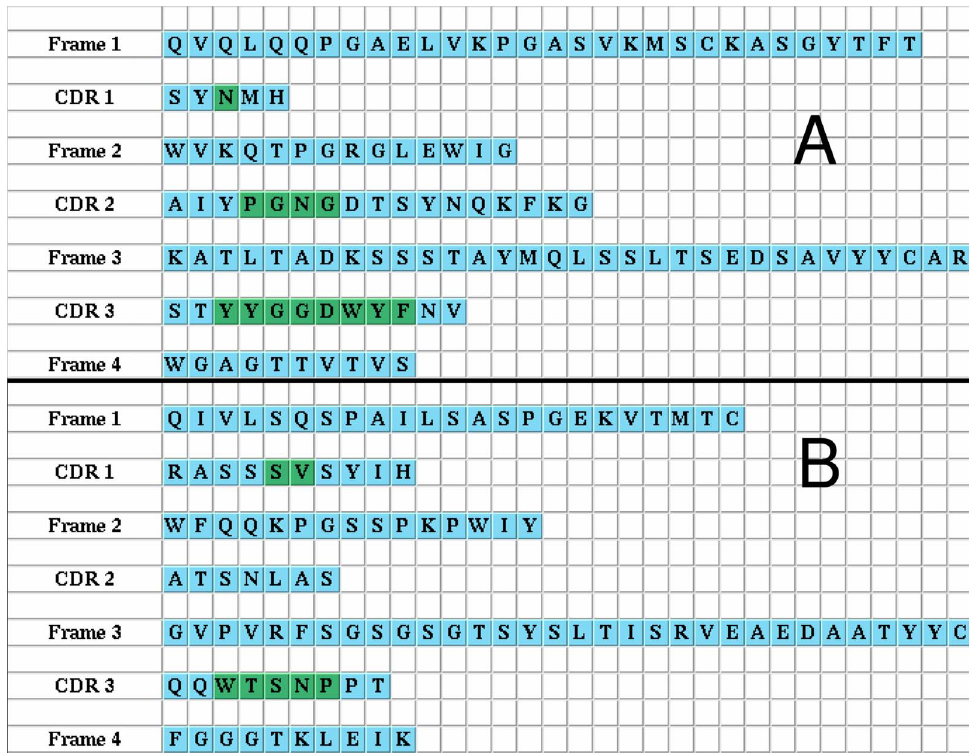
Figure 8. Sequence preparation. Sequence processing is shown for heavy (A) and light chain (B) of Rituximab as an example. CDR residues marked in green belong to structurally varying parts and are not considered in the analysis.